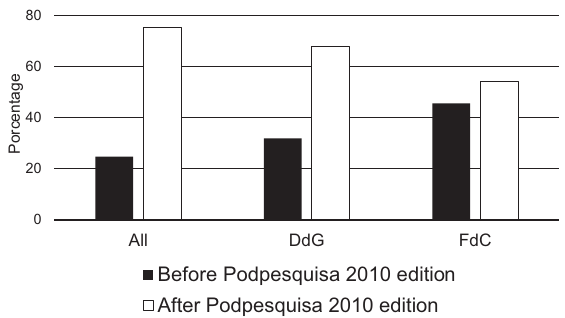
Figure 1 - The period when the participants started to listen to podcasts for the SC podcasts Dragões de Garagem (DdG, n = 325), Fronteiras da Ciência (FdC, n = 473), and the general mean for Brazilian podcasts (All, n =